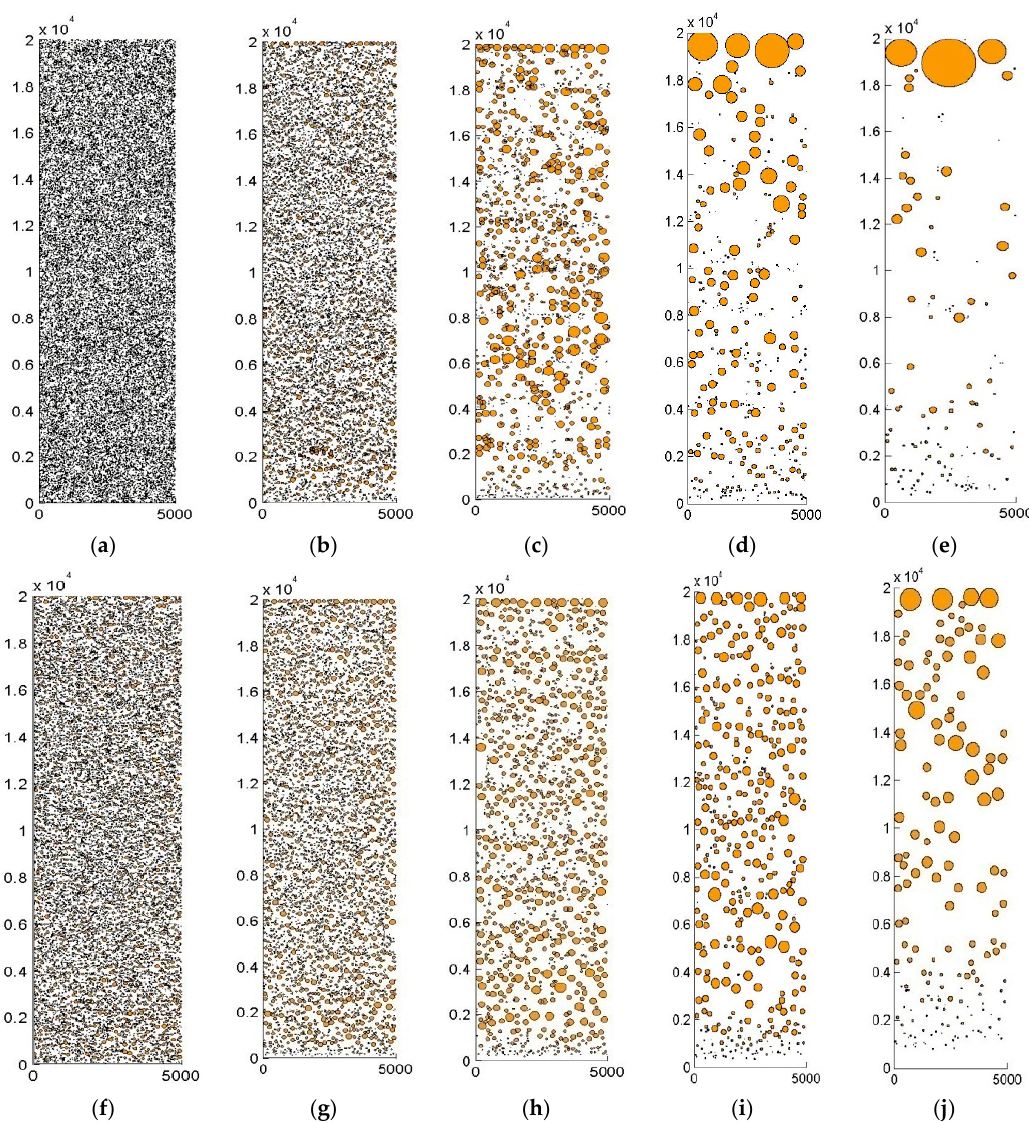
Figure 3. Spatial microstructure evolution with and without HMF. ( a ) 0 T, 0 s; ( b ) 0 T, 0.1 s; ( c ) 0 T, 0.2 s; ( d ) 0 T, 0.3 s; ( e ) 0 T, 0.5 s; ( f ) 12 T, 0.5 s; ( g ) 12 T, 1 s; ( h ) 12 T, 2 s; ( i ) 12 T, 3 s; and ( j ) 12 T, 6 s.